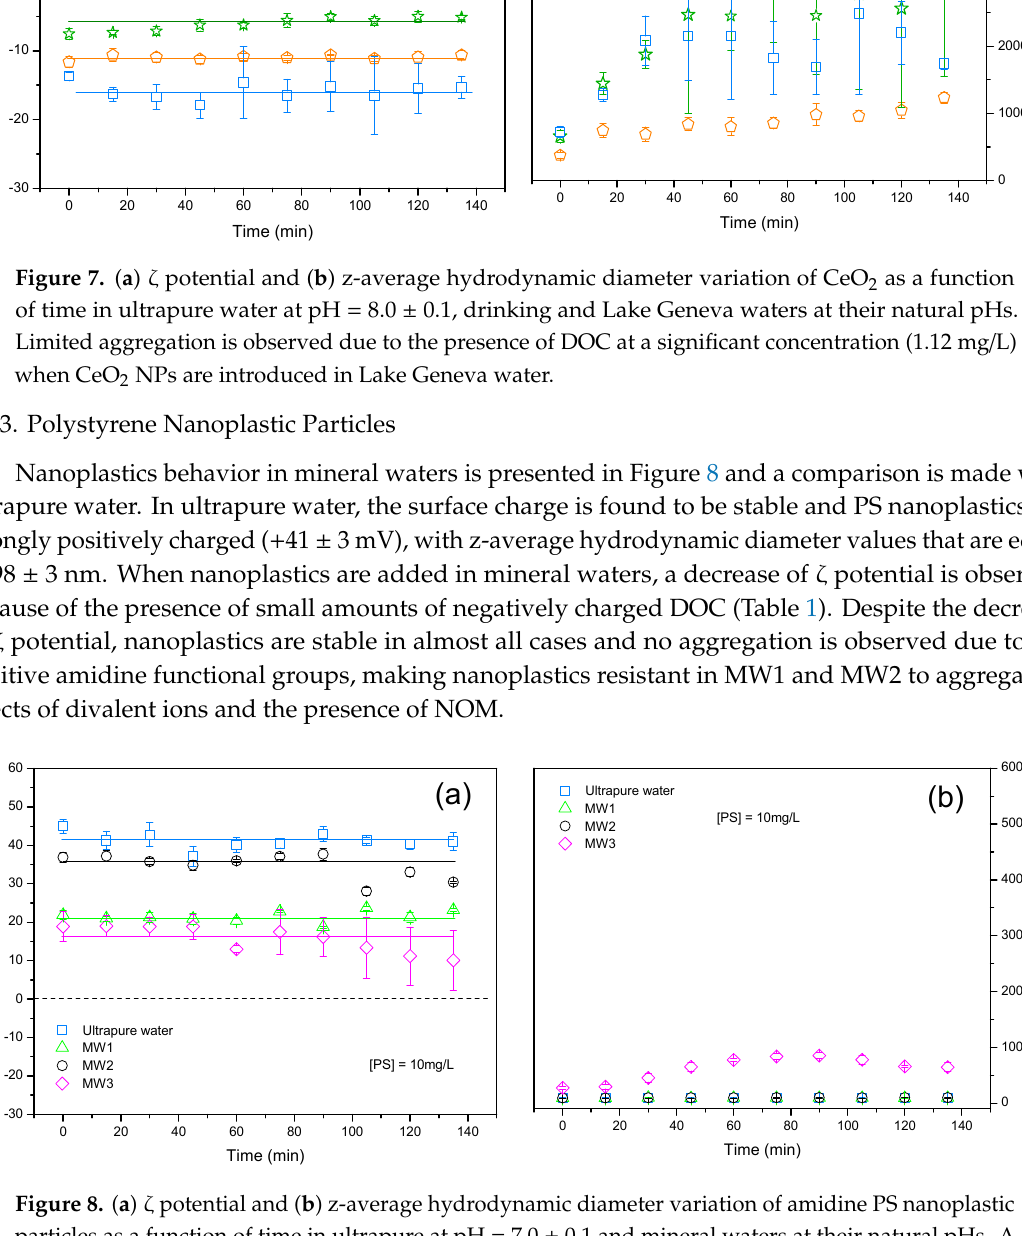
Figure 7. (a) ζ potential and ( b) z-average hydrodynamic diameter variation of CeO 2 as a function of time in ultrapure water at pH = 8.0 ± 0.1, drinking and Lake Geneva waters at their natural pHs. Limited aggregation is observed due to the presence of DOC at a significant concentration (1.12 mg/L) when CeO 2 NPs are introduced in Lake Geneva water.